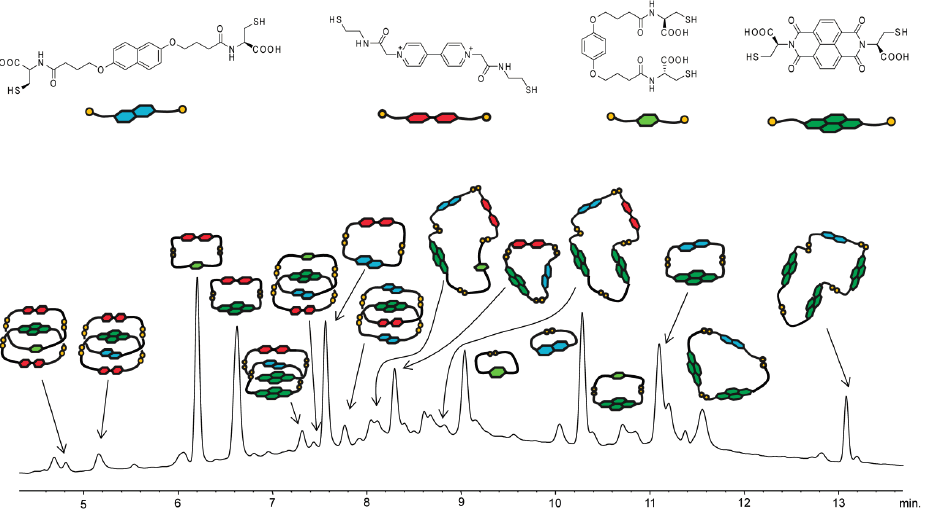
Figure 5. HPLC analysis of an aqueous library composed of 1 , 4 , 6 and 7 (1:1:1:1 molar ratio, 5 mM